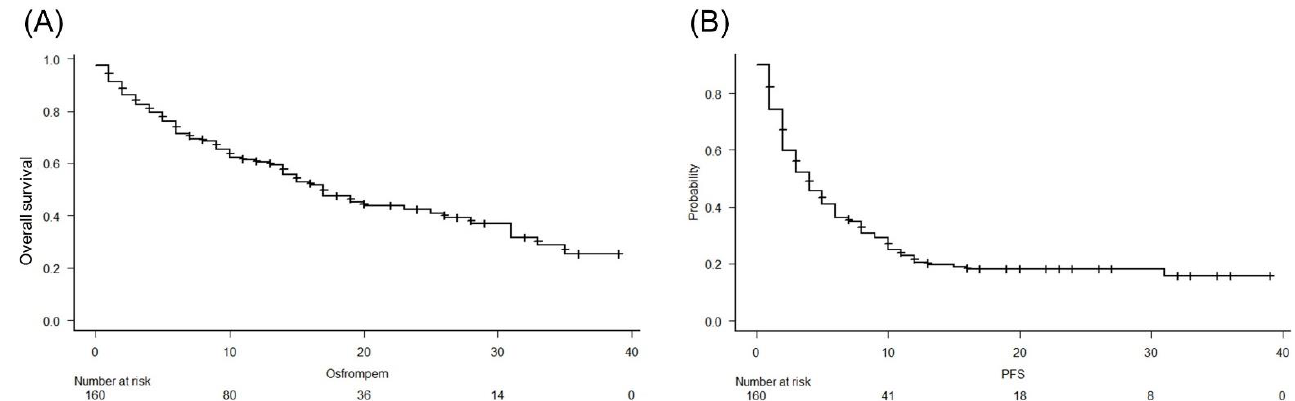
Figure 1. Analysis of overall survival (OS) ( A ) and progression-free survival (PFS) ( B ) using the Kaplan-Meier method in patients with metastatic urothelial carcinoma treated with pembrolizumab. The median OS and PFS in this study were 17 months and 4 months, respectively.